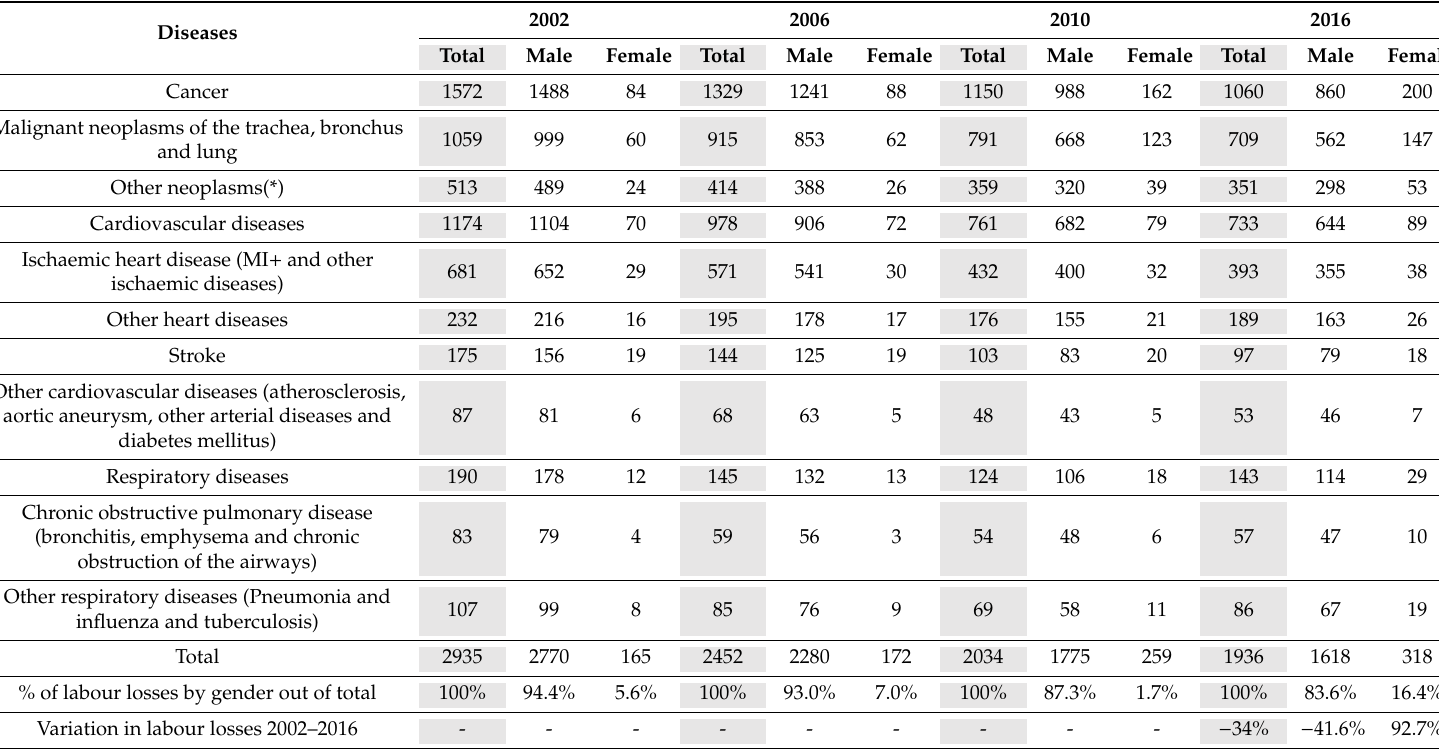
Table A7. Sensitivity Analysis II. Labour losses (constant 2016 euros) (millions of euros). Annual discount rate 0%. Annual labour productivity growth rate 2%. Diseases